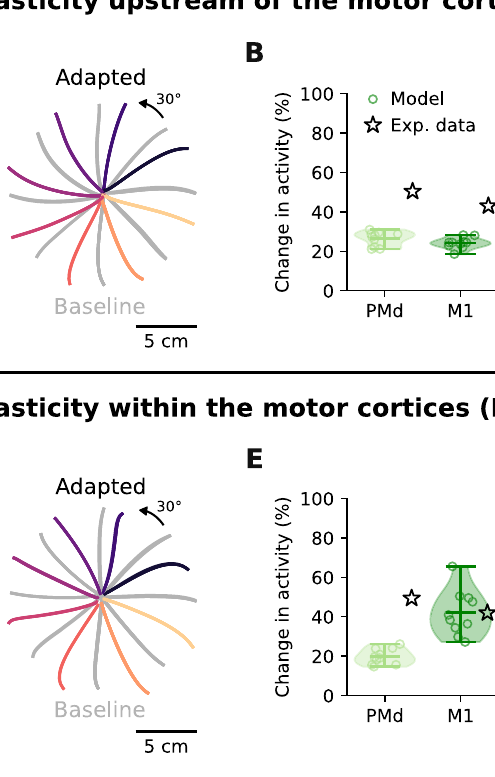
initializations). C Change in covariance following adaptation under H input , and reference values for change in covariance following the initial de-novo training (dashed lines). Data presented as in B . D Hand trajectories after learning under H local . E Change in trial-averaged activity following adaptation under H local . F Change in covariance following adaptation under H local . Data in D – F are pre- sented as in A – C .Source